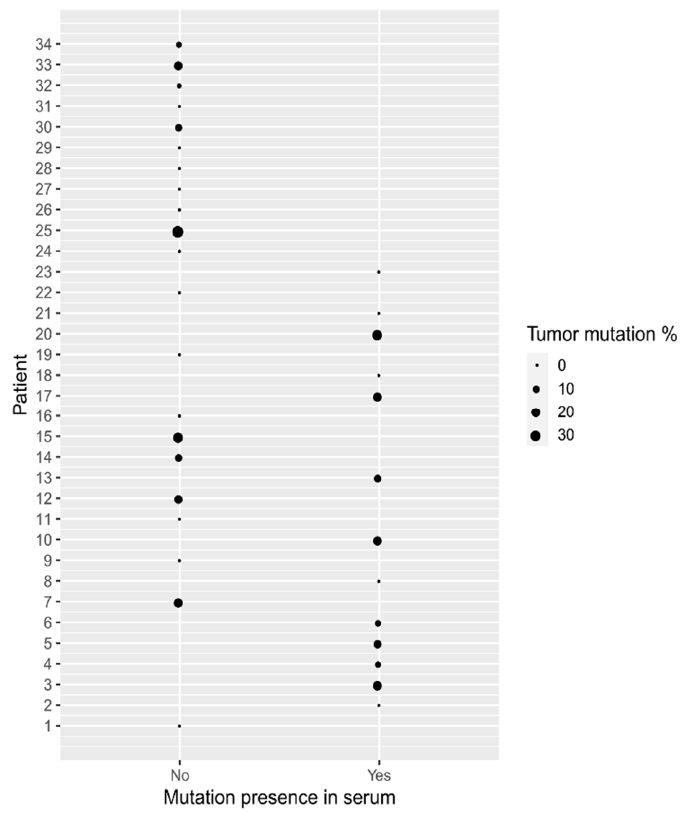
Figure 5. Graphical representation of the relation between the presence of mutation in serum and the percentage of mutation measured in the tumor. The Mann–Whitney U test did not show any correlation between a higher percentage of mutation in tumor and the chance that the mutation will be measured in serum as well.